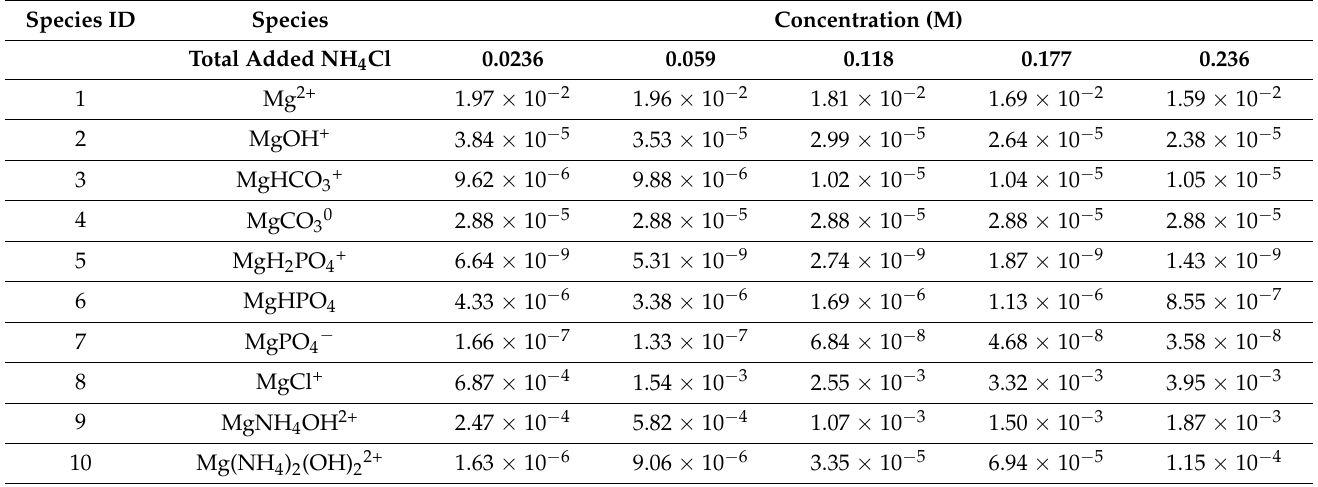
Table A6. Concentrations of dissolved and solid species for Mg silicate at pH 9 calculated using MINEQL+. Values for IDs 25, 27, and 29 were